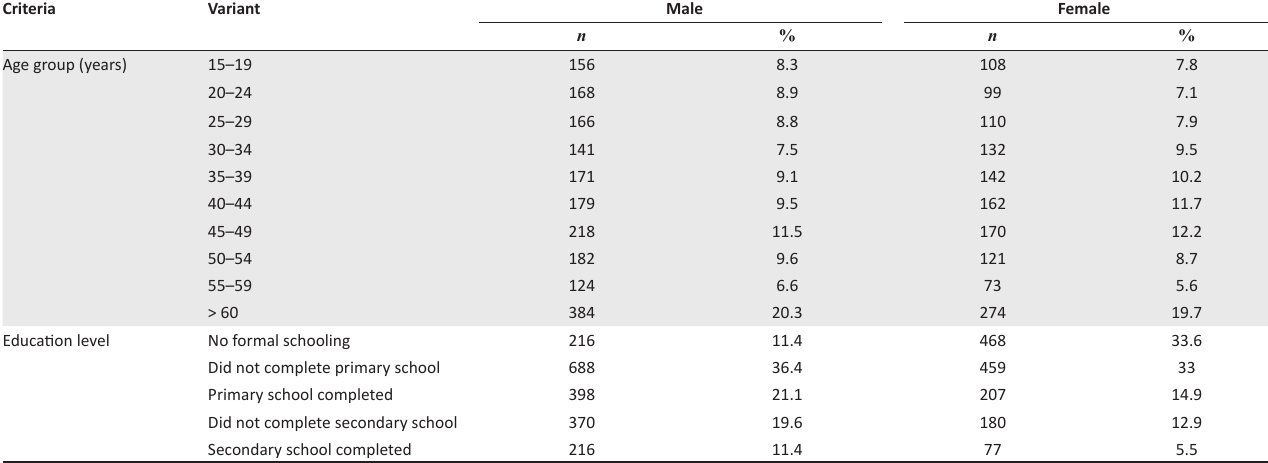
TABLE 1: Age, gender and educational level composition of subjects in the survey area. Criteria